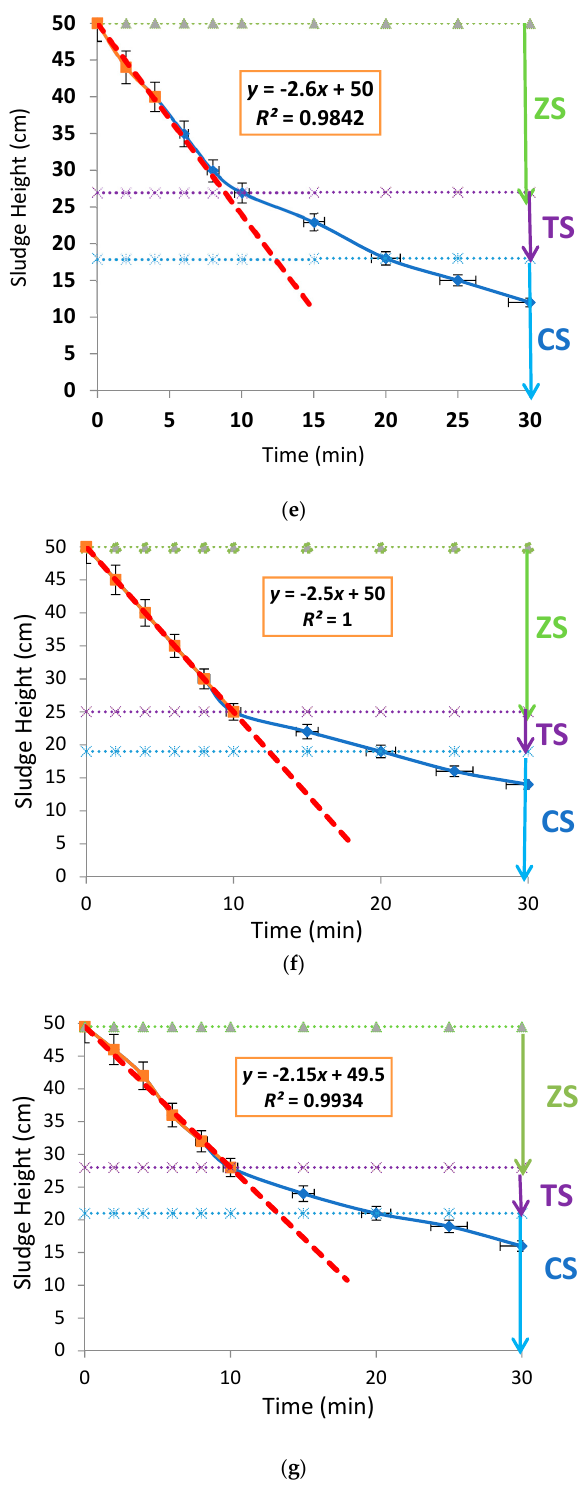
Figure 2. ( a ) Zone settling curve (ZSC) for undosed mixed liquor suspended solids (MLSS); ( b ) ZSC for 20 mg/L aluminium-dosed MLSS; ( c ) ZSC for 50 mg/L aluminium-dosed MLSS; ( d ) ZSC for 100 mg/L aluminium-dosed MLSS; ( e ) ZSC for 150 mg/L aluminium-dosed MLSS; ( f ) ZSC for 200 mg/L aluminium-dosed MLSS; ( g ) ZSC for 250 mg/L aluminium-dosed MLSS; (ZS = zone settling, TS = transition settling, CS = compression settling, error bars represent the standard deviation of the mean). The zone settling velocity (ZSV) was obtained from the slope of the linear